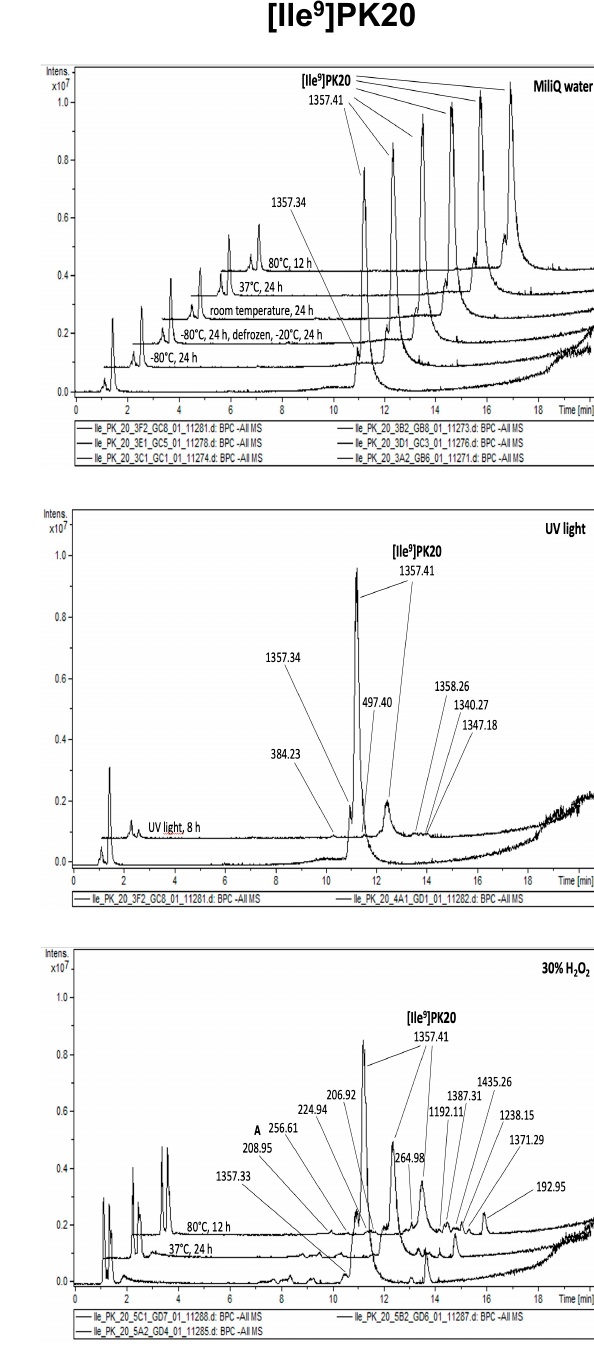
Figure 3. Thermal ( A ) and photolytic ( B ), and oxidative ( C ) PK20 (panel left) and [Ile 9 ]PK20 (panel right) chimera degradation.